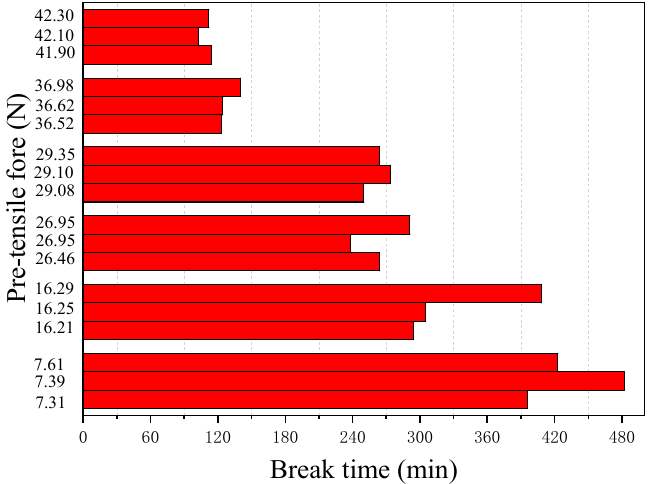
Figure 9. Steel wire break times at different pre-tensile forces (pH = 7, Cl − = 0.0125 mol/L).